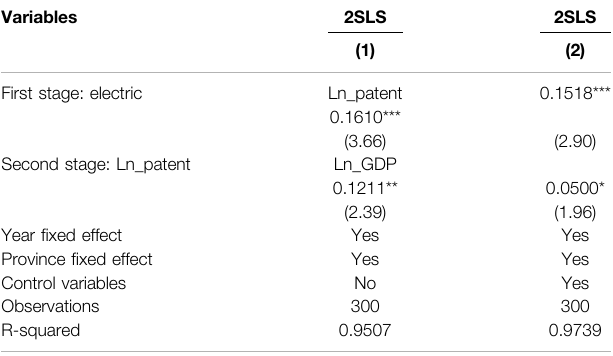
TABLE 7 | Impacts through the innovation of promoting innovation of IEADS. Variables